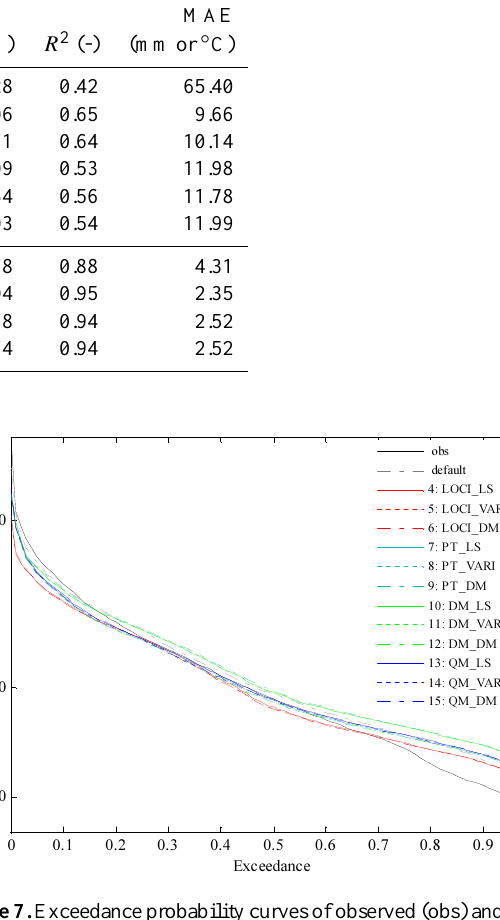
Figure 7. Exceedance probability curves of observed (obs) and sim- ulated streamflow driven by observed (default), and bias-corrected meteorological data (numbers from 4 to 15; see Table 3 for detailed setup of these